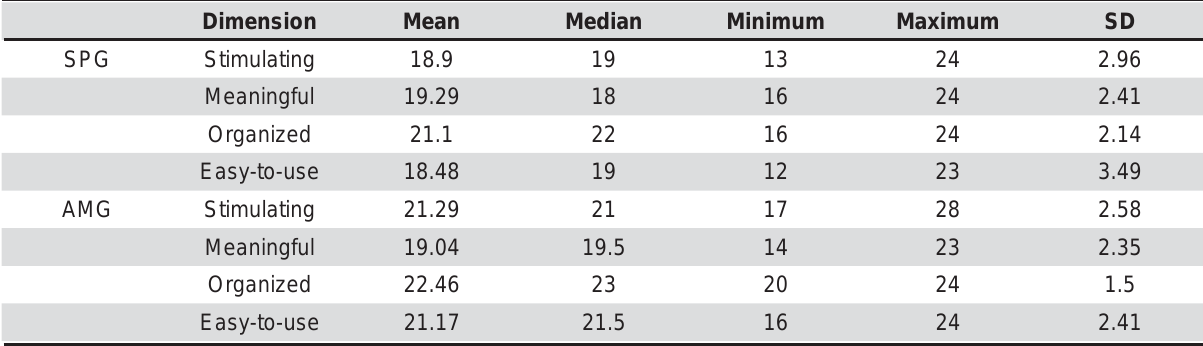
Table 3- Mean, median, minimum, maximum and standard deviation (SD) values assessed by the adapted Web Site Motivational Analysis Checklist (FPM) for the SPG and